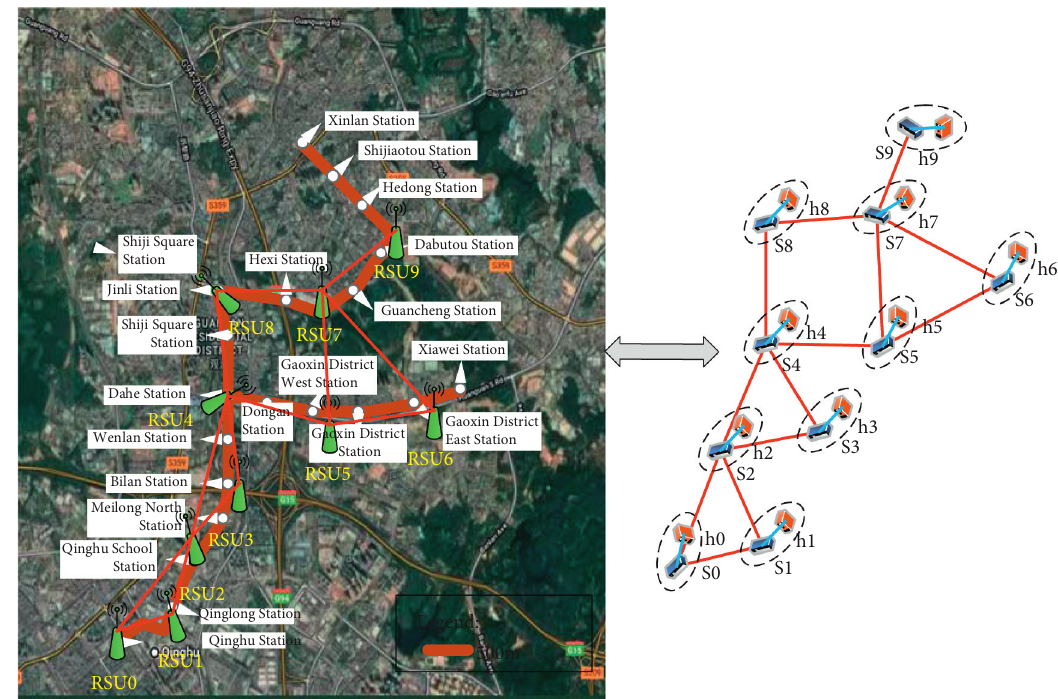
Figure 3: Detailed SDN RSU cloud